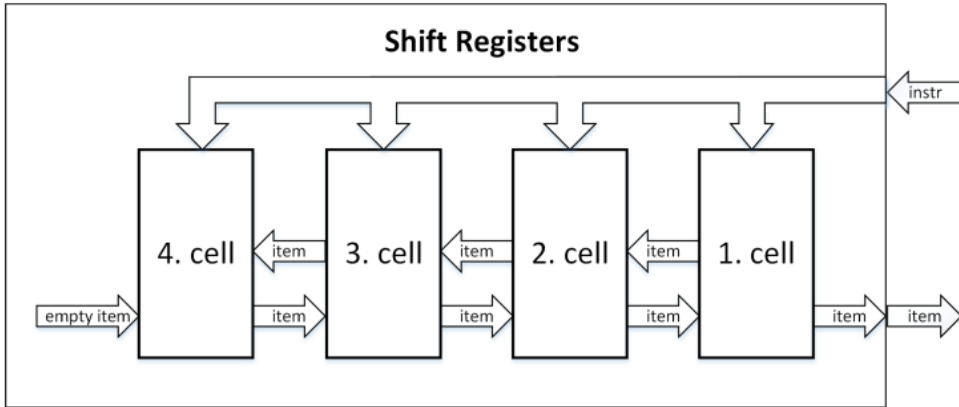
Figure 1. Shift Registers architecture example [48].